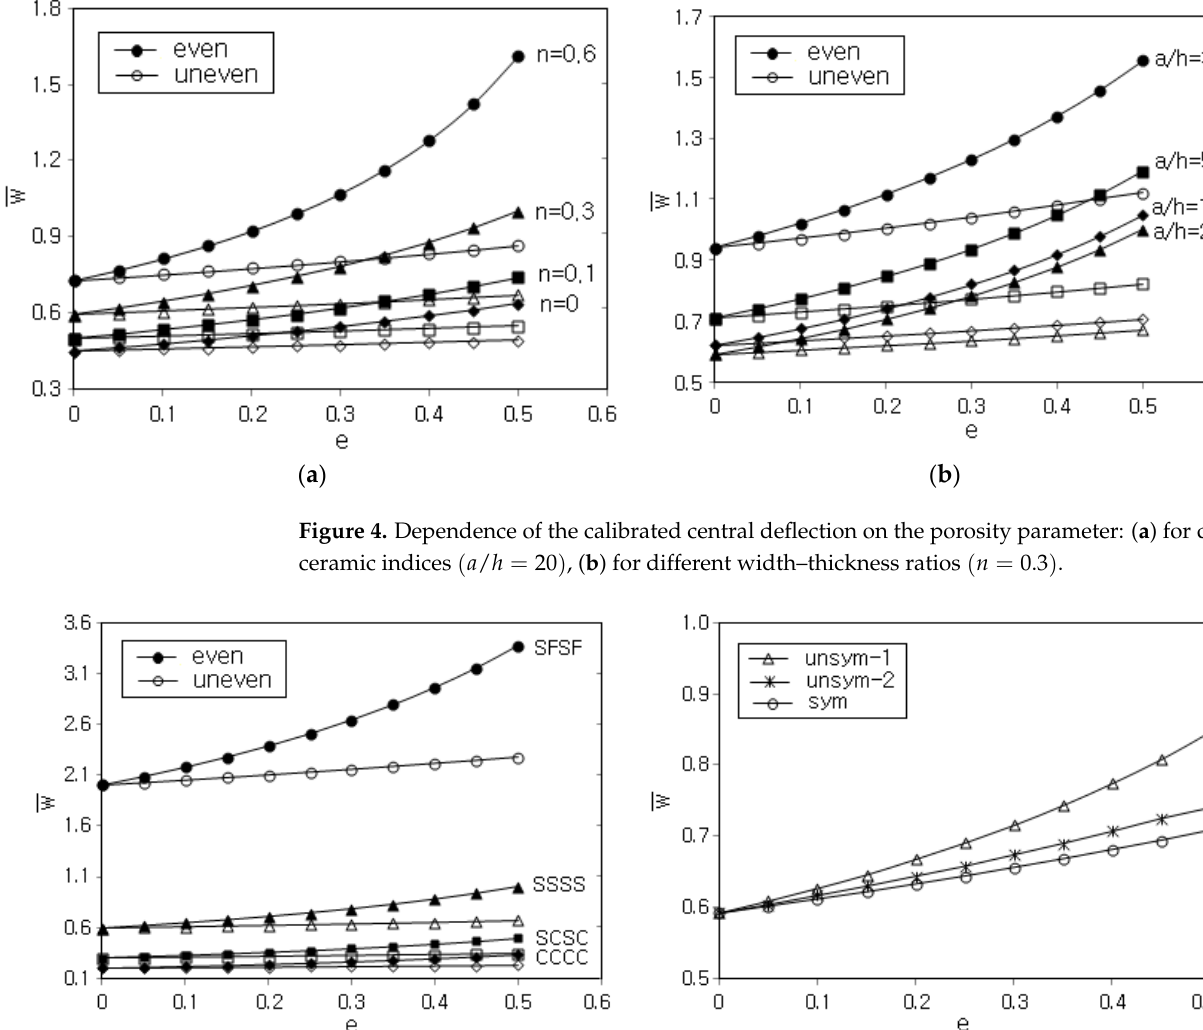
( b ) Figure 6. Dependence of the calibrated stress on the porosity parameter ( 3020 .n,h/a == ): ( a ) axial stress x σ , ( b ) shear stress xz τ .